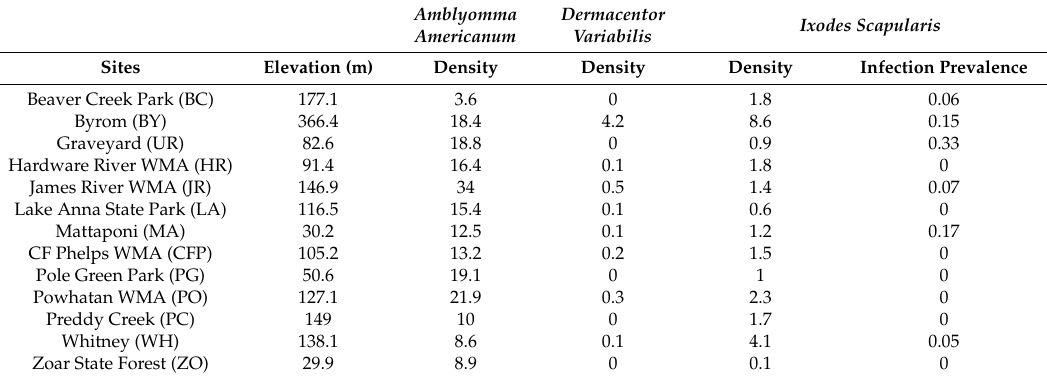
Table 2. Tick densities per 200 m 2 for each field site. Infection prevalence indicates proportion of ticks that tested PCR-positive for Borrelia burgdorferi. Two-letter site codes are indicated by each site name and WMA stands for wildlife management area. Density estimates are per 200 m 2 and are averaged among five transects and two site